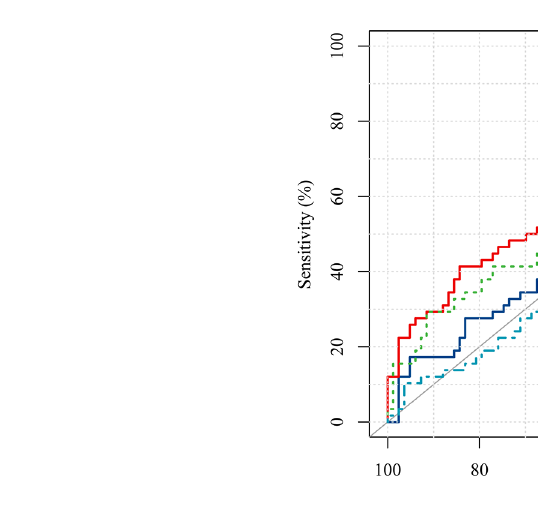
shape (circle) (4) and heterogeneity (8). Combined with the above criteria, the “ largest short-axis diameter lymph node ” was de fi ned as the highest risk lymph node in the region. 2. Rectal cancer ’ s lymph node metastasis area is relatively fi xed. Langman